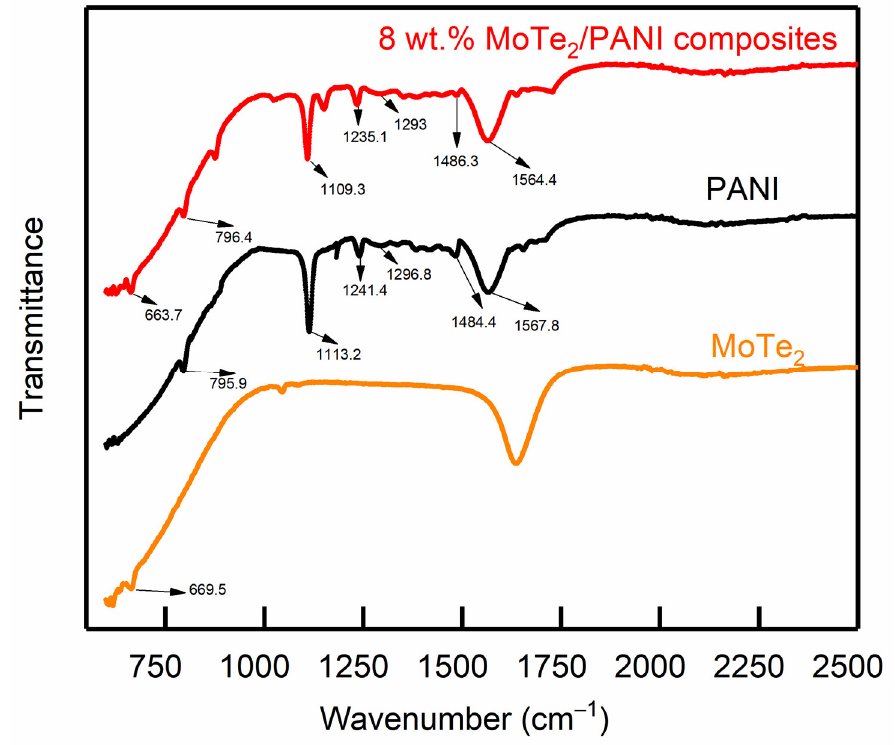
Figure 4. FTIR spectrum of MoTe 2 nanosheets, pure PANI and MoTe 2 /PANI nanocomposites.